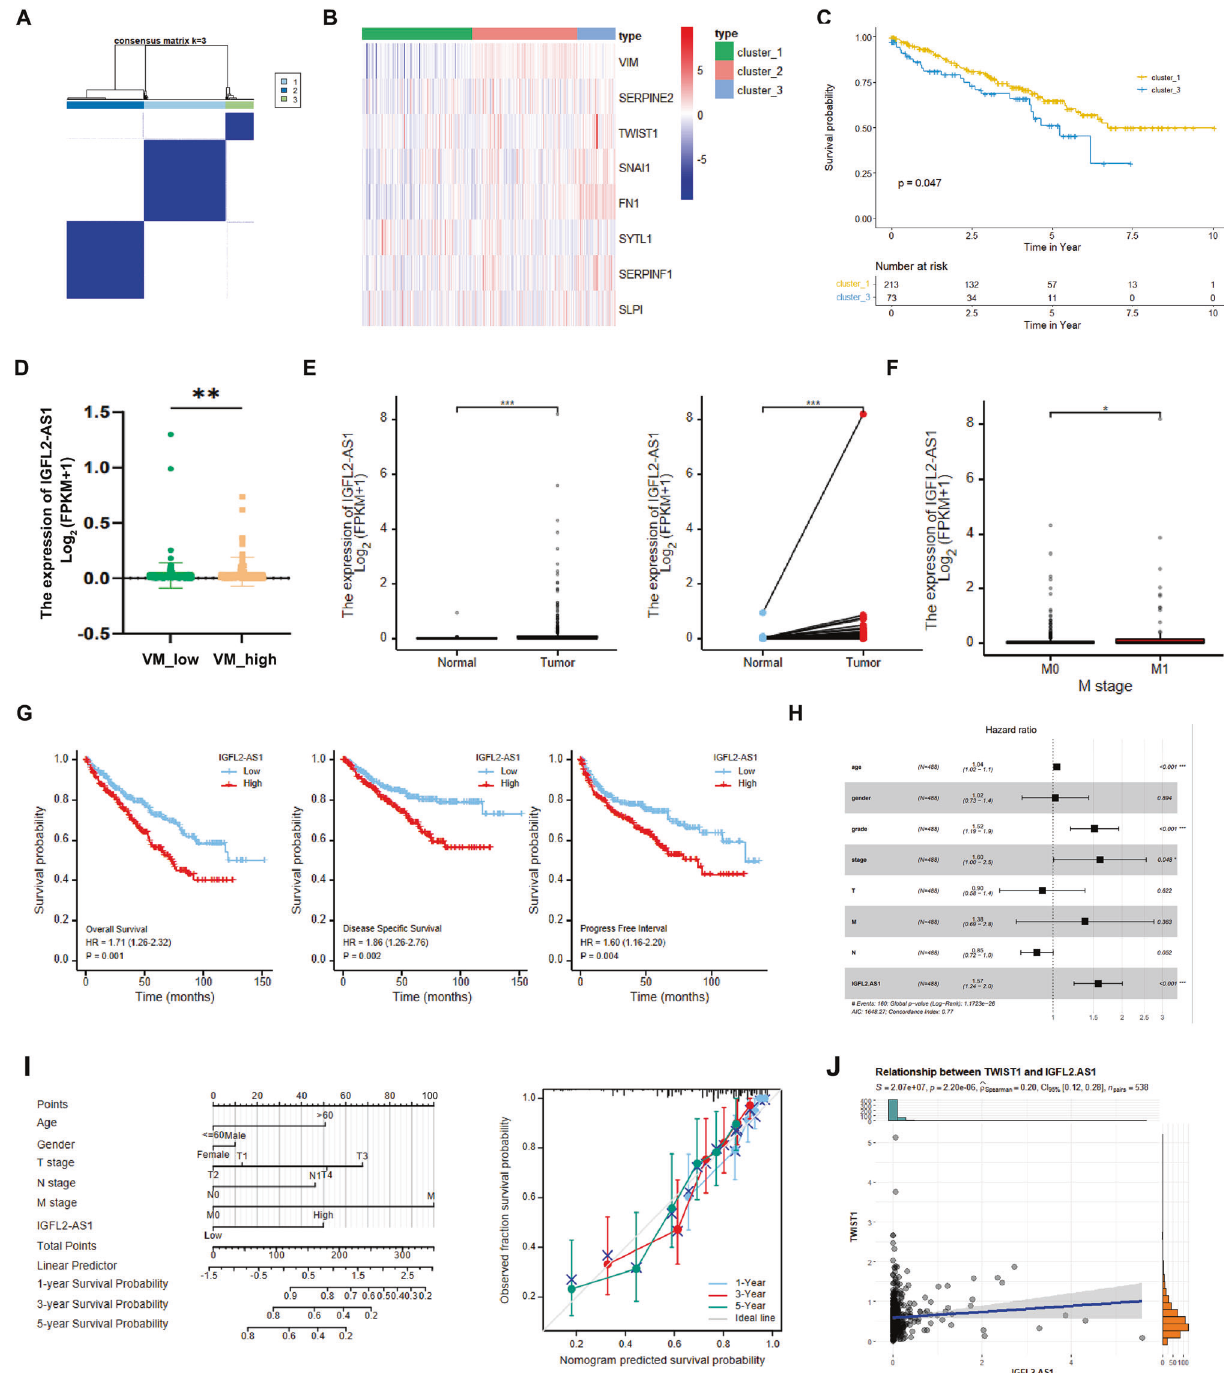
Fig. 6 Assessment of the clinical values of IGFL2-AS1 in ccRCC patients. A Consensus matrix when k = 3. B A heat-map of expression pattern of VM related genes in individual cluster. C VM_high (cluster 3) patients experienced shorter survival time than VM_low (cluster 1) counterparts. D IGFL2-AS1 was over-expressed in VM_high subtype ccRCC. E the expression level of IGFL2-AS1 was evidently higher in ccRCC as compared to normal kidney tissues. F IGFL2-AS1 was highly expressed in distant metastatic ccRCC as compared to localized controls. G Kaplan – Meier survival analyses indicated ccRCC patients with high IGFL2-AS1 levels had worse OS (Overall Survival), DSS (Disease Free Survival) and PFI (Progression Free Interval) than those with low IGFL2-AS1 level. H Multivariate Cox regression analysis of Age, Gender, TNM, T stage, grade and IGFL2-AS1. I IGFL2-AS1 based Nomogram prediction model. J IGFL2-AS1 and VM gene TWIST1 was highly correlated at expression level in TCGA-KIRC. * P < 0.05; ** P < 0.01; *** P <